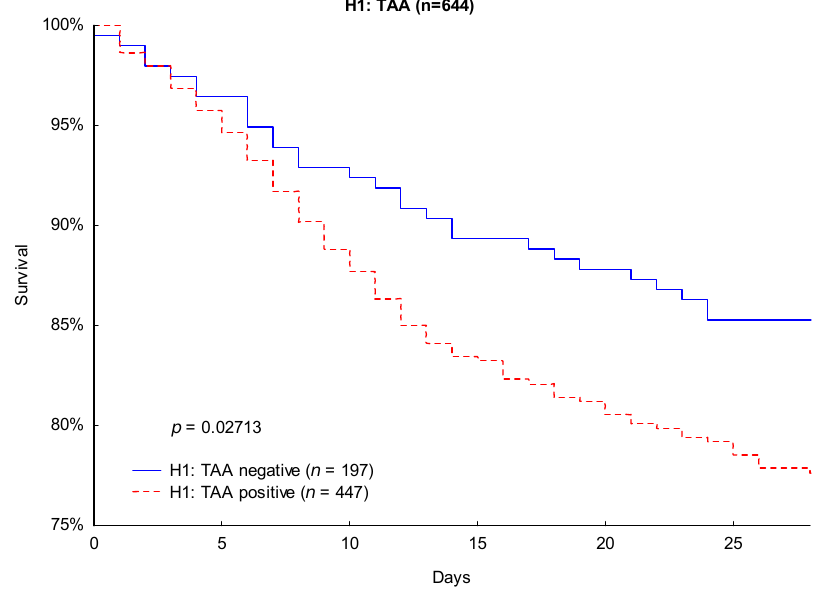
Figure 5 . Kaplan–Meier survival analysis (28 days) with regard to the CTLA ‐ 4 haplotype H1: TAA.